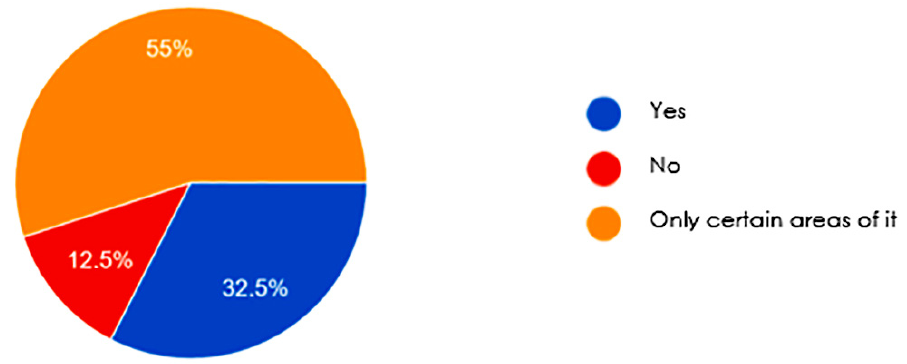
Figure 14. Students’ interest in math.